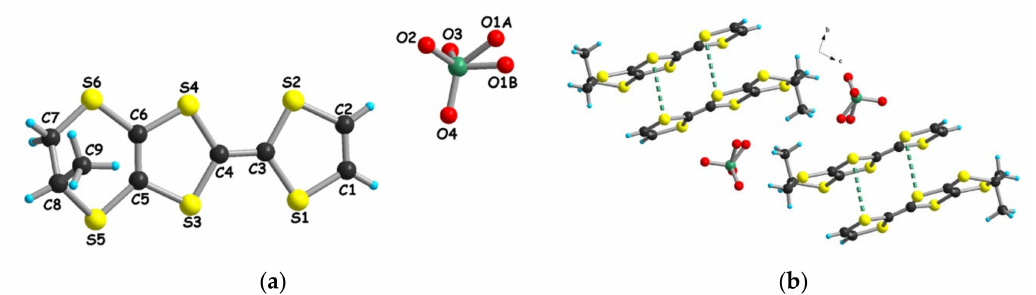
Figure 1. ( a ) Molecular structure of [( rac )- 1 ]ClO 4 (O1 atom is disordered). Only the ( S ) enantiomer of the donor is shown; ( b ) Packing diagram of [( rac )- 1 ]ClO 4 in the bc plane, with an emphasis on the intradimer S ··· S short contacts (3.38 and 3.47 Å, green dotted lines).